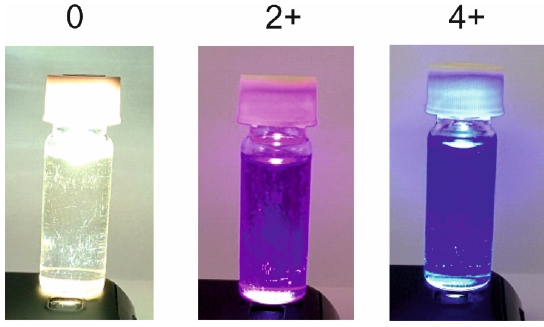
Figure 8. Changes in the UV/Vis/NIR spectra on oxidation of neutral macrocycle 3 to the dicationic state 3 2+ ( left ) and from the di- to the tetracationic state 3 4+ ( right , 1,2-C 2 H 4 Cl 2 , NBu 4+ PF 6 − , r.t.).